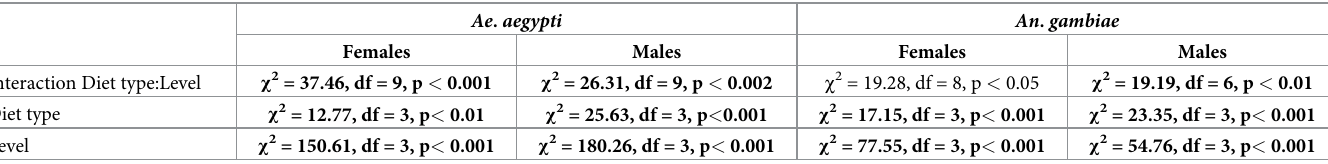
Table 4. Development rate statistics.